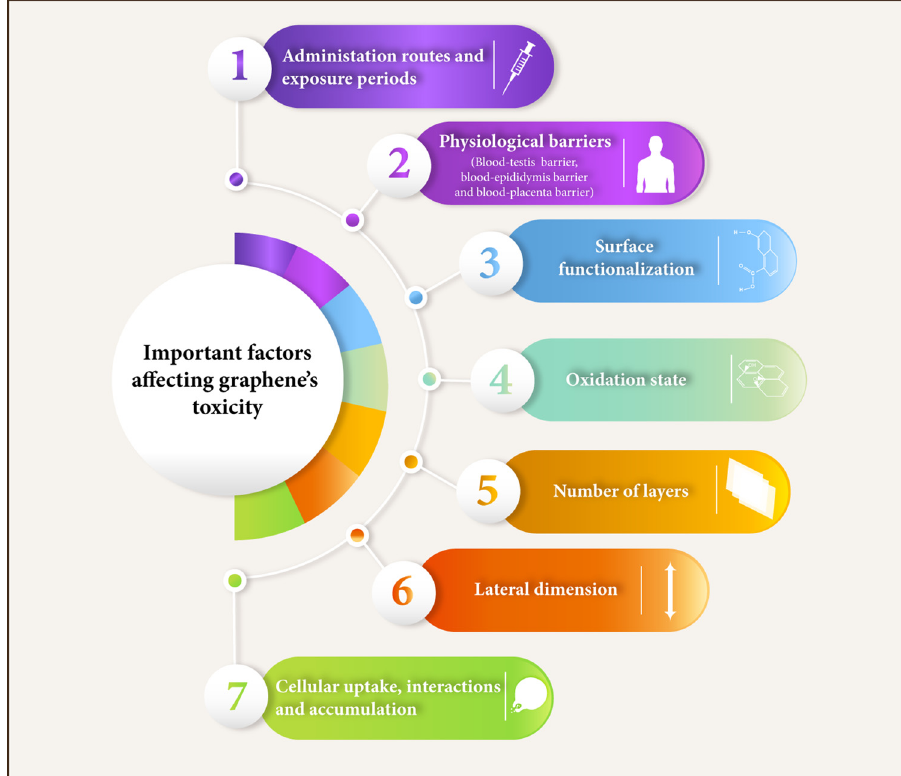
Figure 3: Main underlying factors that in fl uence graphene